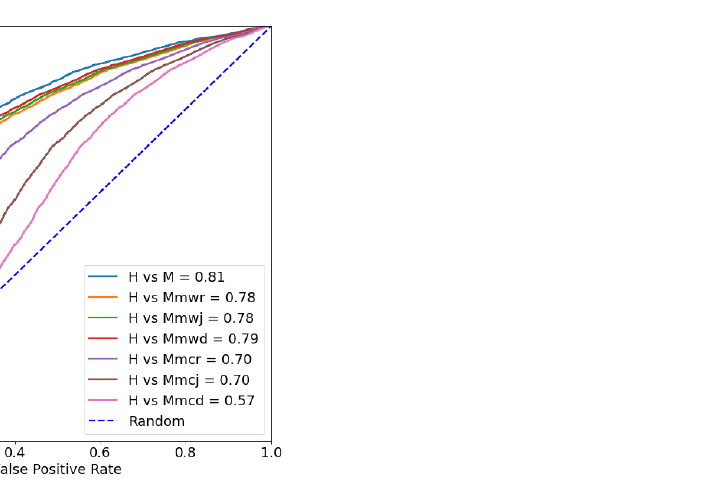
Figure 5. The area under the receiver operating characteristic curve for RoBERTa-RR on out-of- distribution data.